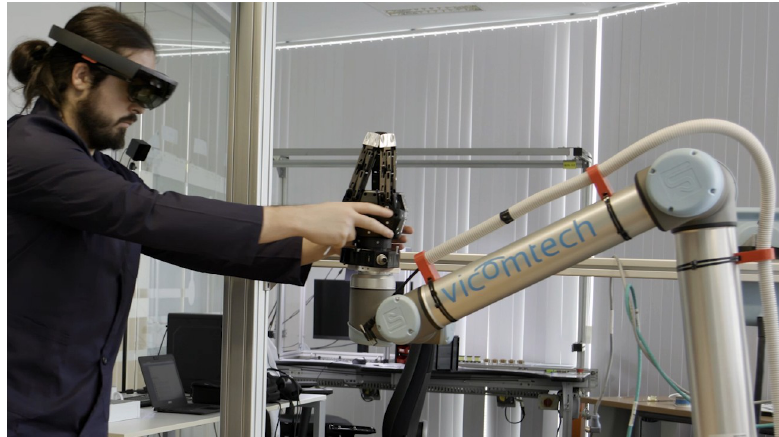
Figure 3. An operator uncoupling the Universal Robot’s Gripper.